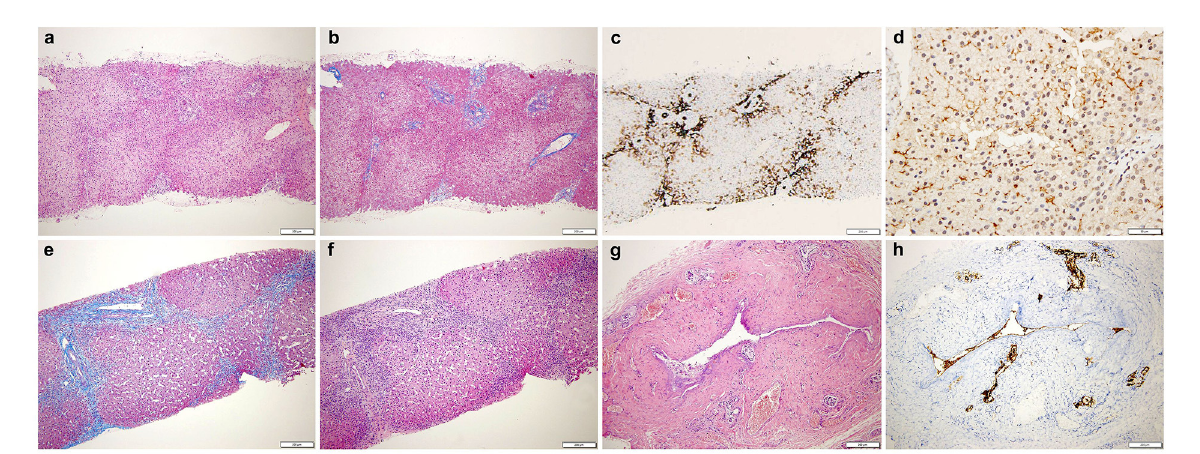
6 months after surgery after